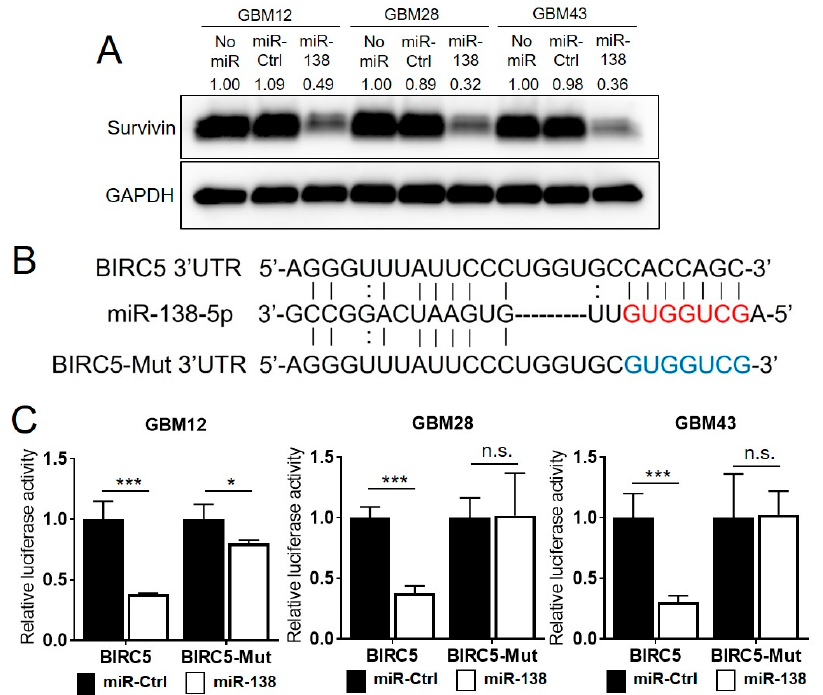
Figure 4. miR-138 negatively regulates the expression of Survivin through direct targeting its 3 ′ UTR. ( A ) Western blotting on GBM cells (GBM12, GBM28 and GBM43) with transient overexpression of miR-138. The protein expression levels of Survivin were significantly decreased by imR-138 compared to miR-Ctrl treated GBM cells. Relative fold change of Survivin expression by miR-138 or miR-Ctrl was compared to the No miR control in each cell. ( B ) Schematic diagram of 3 ′ UTR sequences of Survivin containing a predicted miR-138 binding site (red letters). BIRC5-Mut construct contains the mutated sequences in the seed regions (blue letters). ( C ) Luciferase reporter assays for direct binding of miR-138 to the 3 ′ UTR of BIRC5. GBM cells were co-transfected with miR-138 and the luciferase reporter plasmid DNA containing BIRC5 3 ′ UTR, or BIRC5-Mut sequences respectively. The cells were further treated with TMZ for 4 days, and the repression of luciferase activity by miR-138 was analyzed by Dual Luciferase Assay kit. The relative luciferase activity values were normalized to Renilla luciferase activity as internal control. All error bars indicates standard devia- tions ( n = 3), and the p -values were determined by two-tailed student t -test. * p < 0.05, *** p < 0.001, n.s = not significant.